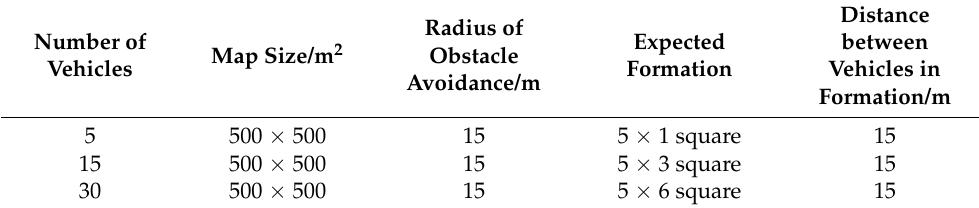
Table 1. Experimental environmental parameters under obstacle-free maps.